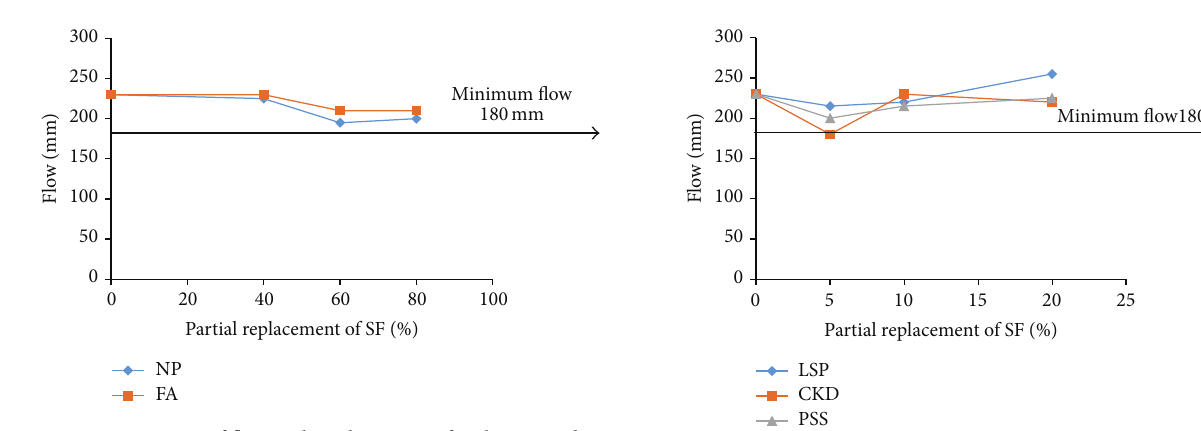
Figure 3: Variation of flow with replacement of SF by NP and FA.